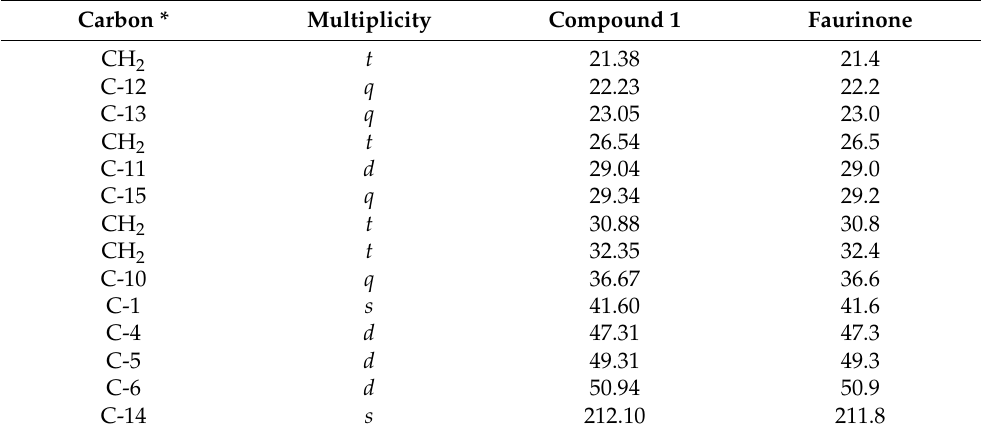
Table 4. Experimental and literature values [27] of 13 C NMR shifts (ppm) of faurinone.